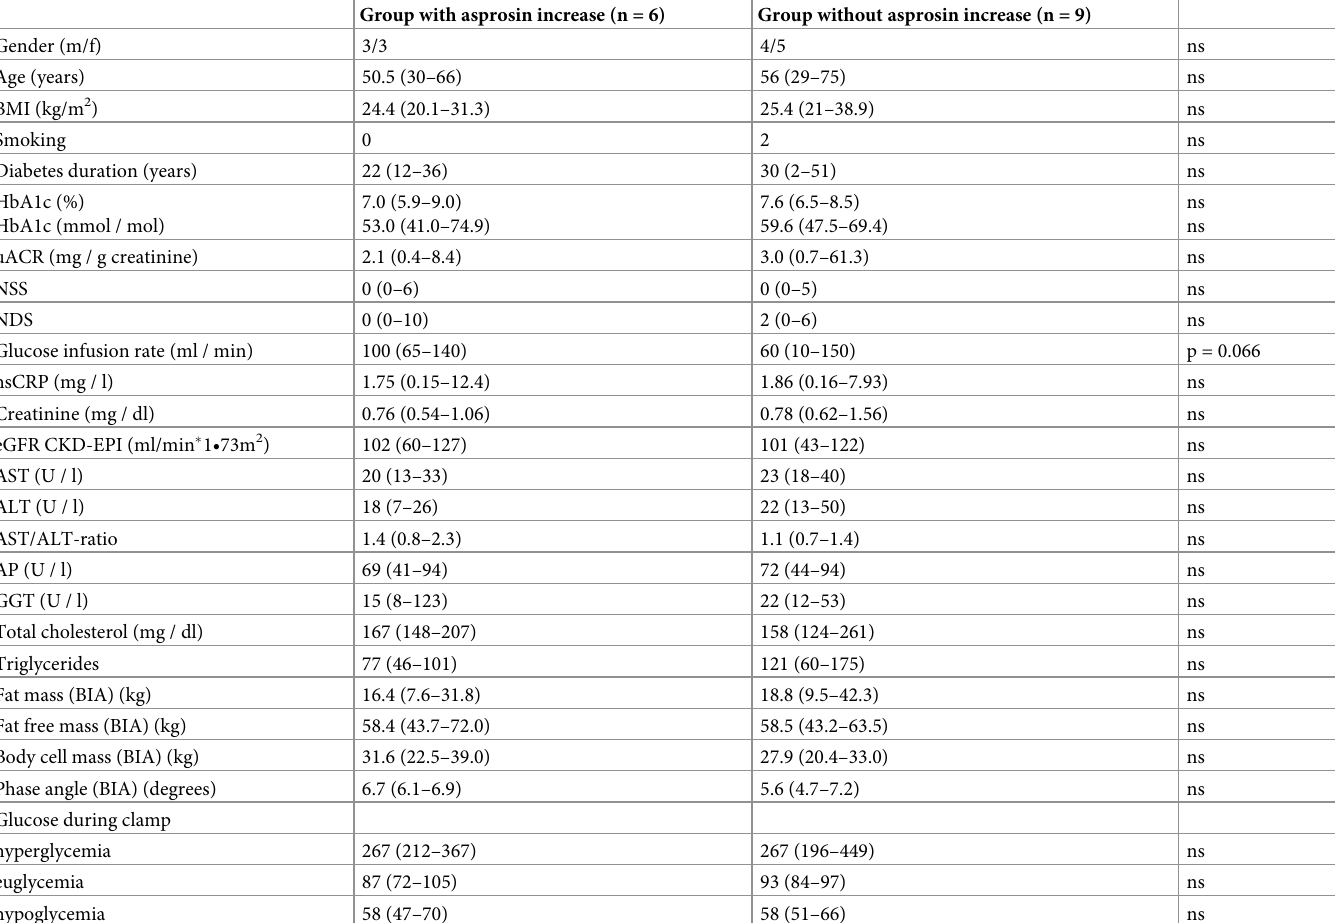
Table 1. Patients’ characteristics and group comparison between patients with and without asprosin increase during hypoglycemic phase. Group with asprosin increase (n = 6)